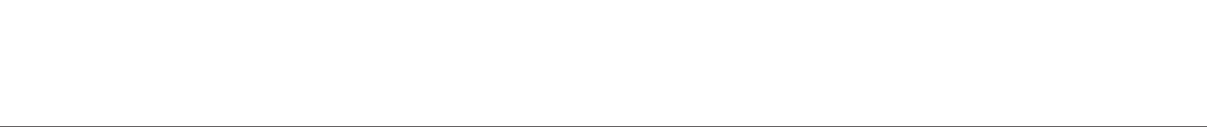
Frontiers in Sustainable Food Systems |